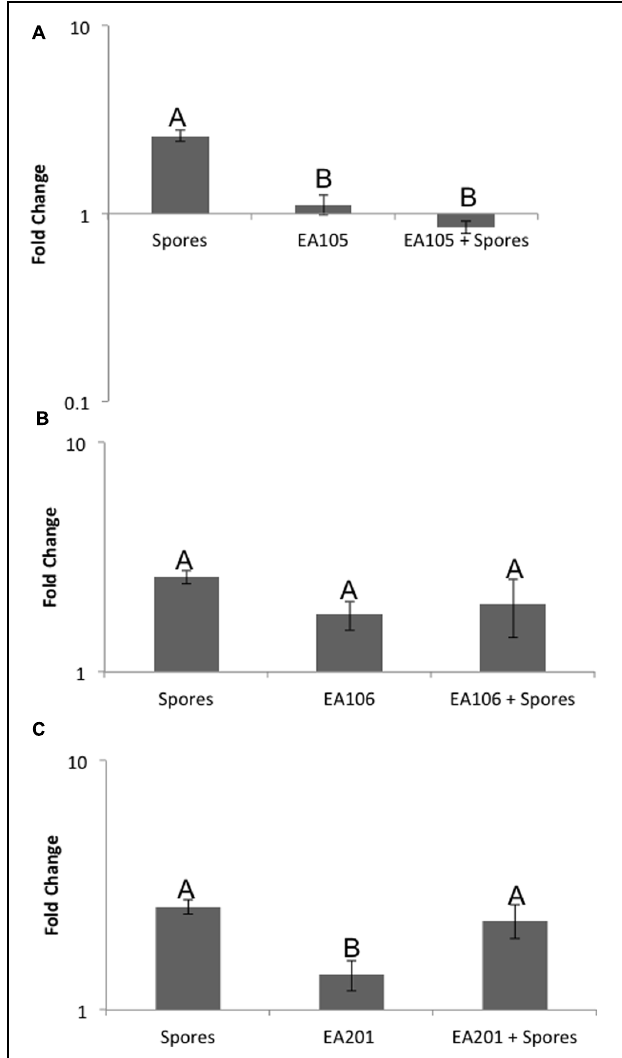
FIGURE 1 | Expression of ABA biosynthesis gene, NCED3 . Roots were inoculated with either (A) EA105, (B) EA106, or (C) EA201, 24 h prior to being exposed to spores. Error bars indicate standard error based on three biological replicates, each including five plants. Different letters represent a statistically significant difference based on the Tukey-Kramer test, p <